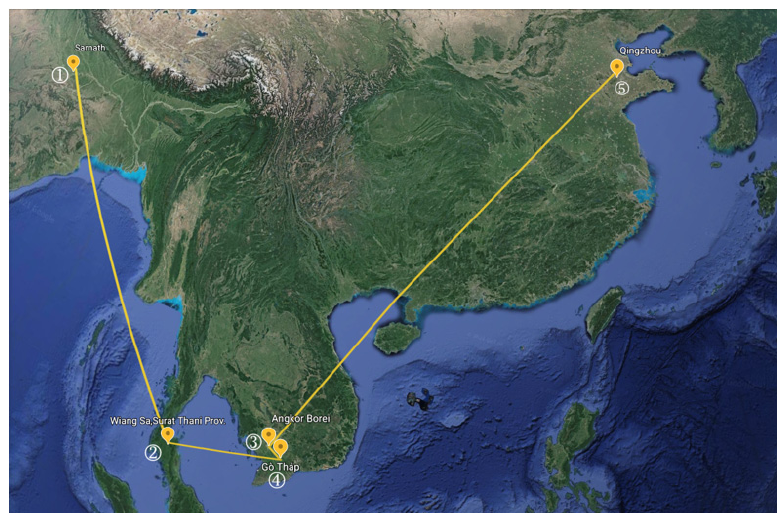
Figure 2. The schematic diagram of transmission route of standing Buddha statues with diaphanous robe draped over both shoulders (type A). ① Sarnath, Northeast India; ② Wiang Sa, Surat Thani, Thailand, North-Central Malay Peninsula; ③ Angkor Borei, Ta Keo, Cambodia, Lower Mekong; ④ Mekong Delta; ⑤ Longxing Temple Site, Qingzhou, Shandong Peninsula, China. Note: The lines in the picture are connected according to archaeological excavation or collected finds and indicate the approximate transmission route, not the exact one. The same goes for the maps below.